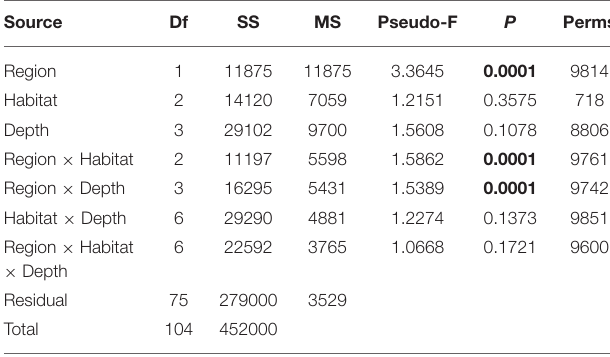
TABLE 1 | Results of PERMANOVA analyses testing for the effects of Region (Hikurangi Margin versus Bay of Plenty), Habitat (slope, canyon, and seamount), Depth (700, 1000, 1200, and 1500 m), and their interactions on megafauna community structure, after accounting for the effect of spatial covariates (latitude and longitude; results not